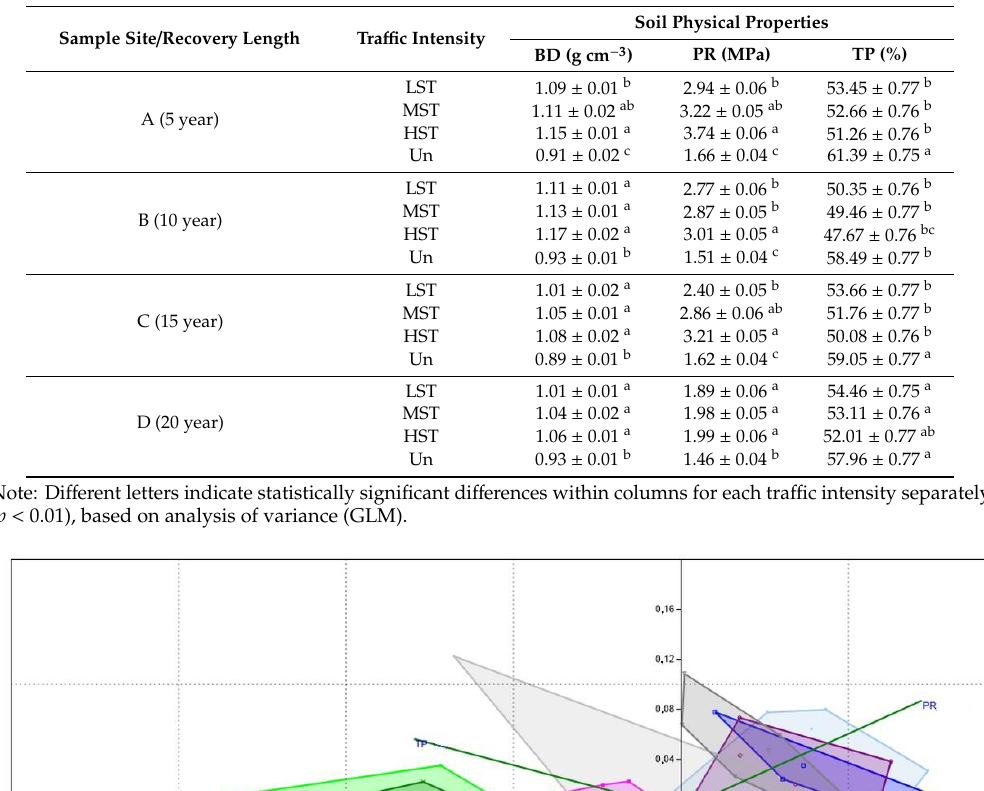
Table 4. Means ± standard deviation of different physical soil properties on skid trails in different treatments. BD: soil bulk density; PR: penetration resistance; TP: total porosity. LST: skid trail with low traffic intensity; MST: skid trail with medium traffic intensity; HST: skid trail with high traffic intensity, Un: Undisturbed area.